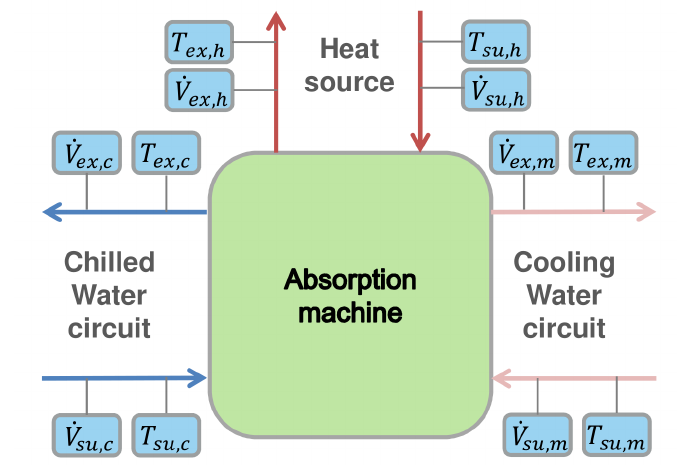
Figure 11. Schematic view of the inputs/outputs of an absorption